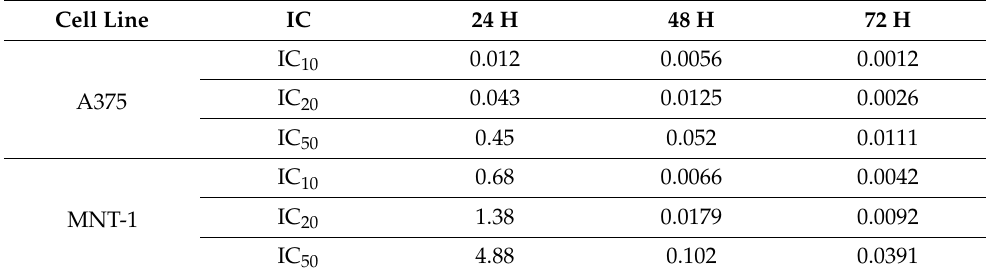
Figure 1. Effect of DOX on cell viability of A375 and MNT-1 cells. Cells were exposed to different concentrations of DOX for 24, 48, and 72 h, and cell viability was determined using MTT assay. Data shown are mean values ± standard deviation of three independent experiments with four technical replicates each. *—indicates statistical significance in comparison to the respective control ( p < 0.05). Table 1 shows that the ICs decreased when the exposure time increased. In addition, MNT-1 cells were less responsive to DOX, presenting higher ICs than A375 cells. In fact, the calculated IC 50 for 24 h of exposure was 4.88 µ M for MNT-1 cells and 0.45 µ M for A375 cells, corresponding to a DOX IC almost 11-times higher for MNT-1 than for A375. Even in the longer exposure time, MNT-1 cells had a DOX IC 50 3.5-fold higher than A375 cells. Table 1. Inhibitory concentrations (ICs) obtained for 24, 48, and 72 h DOX exposure. Values are expressed in μ M.